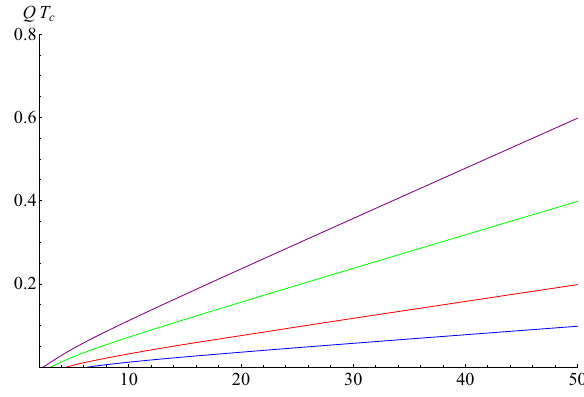
Fig. 4 We plot the reduced temperature T + Q on the event horizon (left) and the reduced temperature T c Q on the cosmological horizon (right) in terms of the corresponding reduced horizon radius, for the